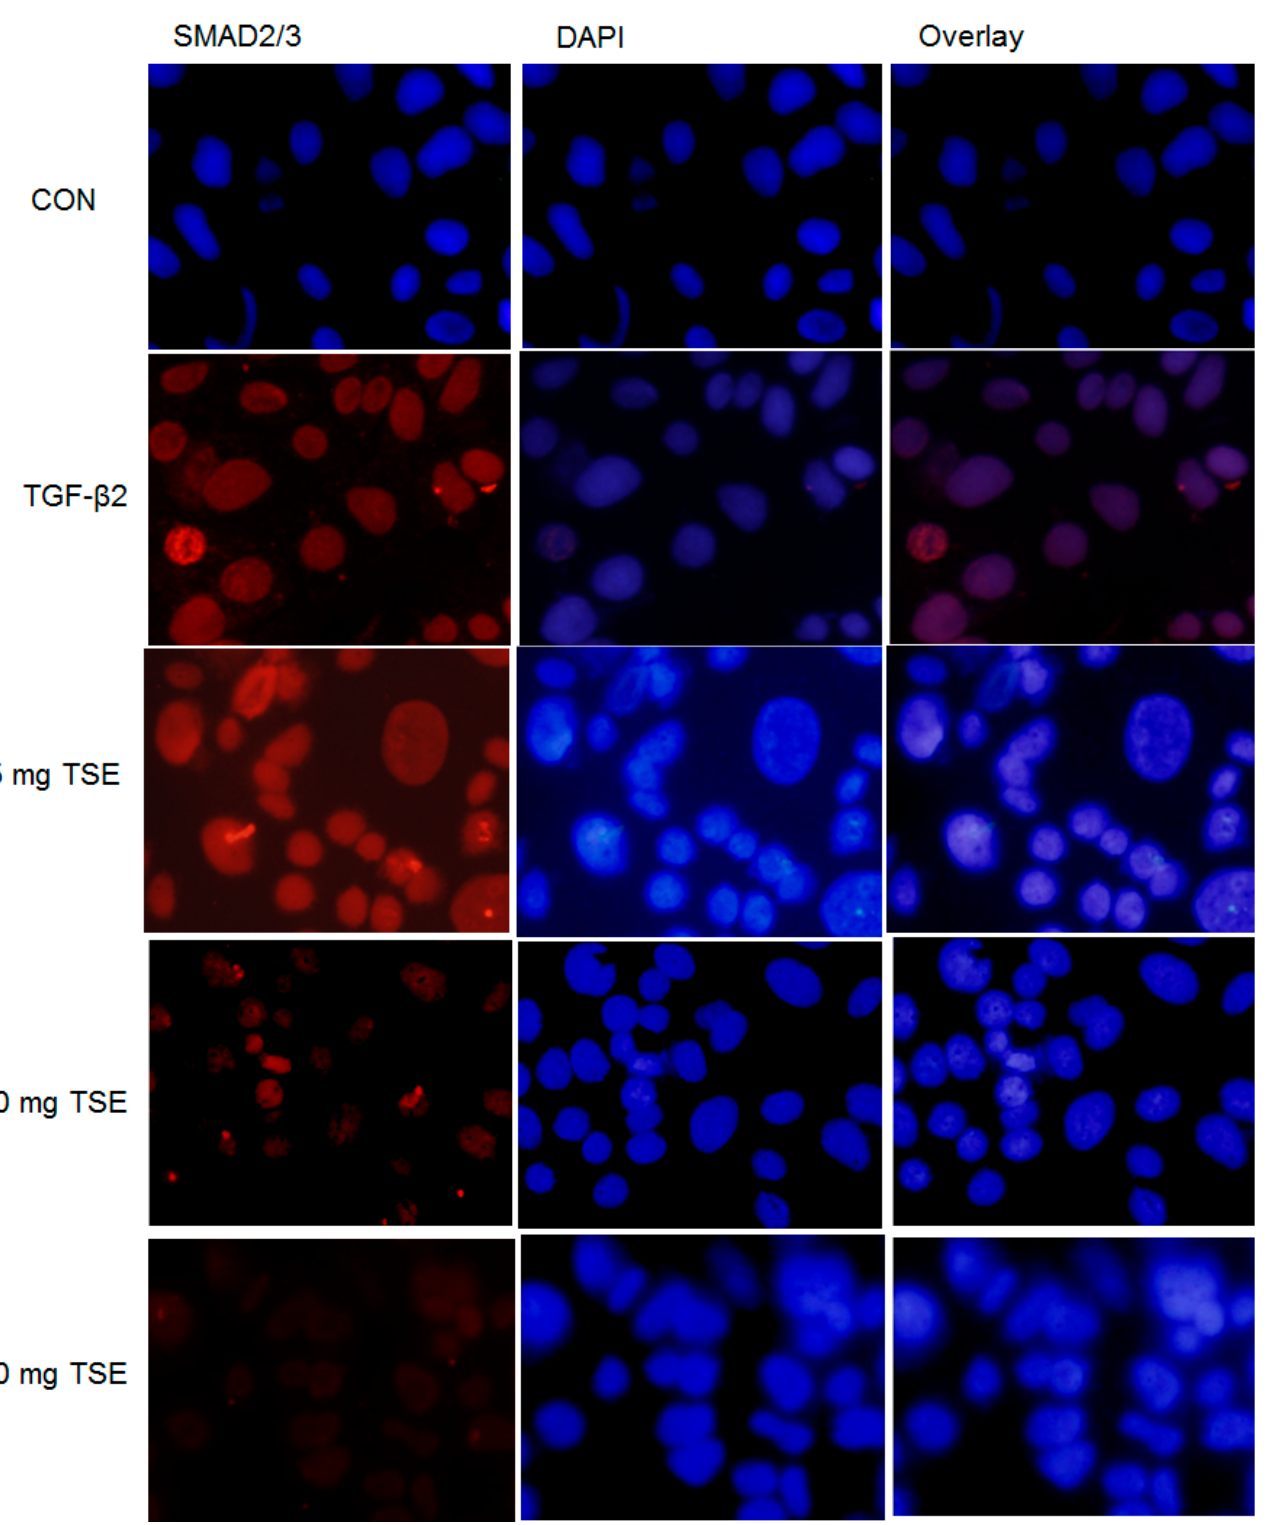
Figure 6. Effects of TSE on epithelial–mesenchymal translocation of SMAD2/3 in cells using confocal microscopy. The mesenchymal phenotypic marker SMAD2/3 (red) in cells. The nuclei were stained with DAPI (blue). Magnification, ×200.